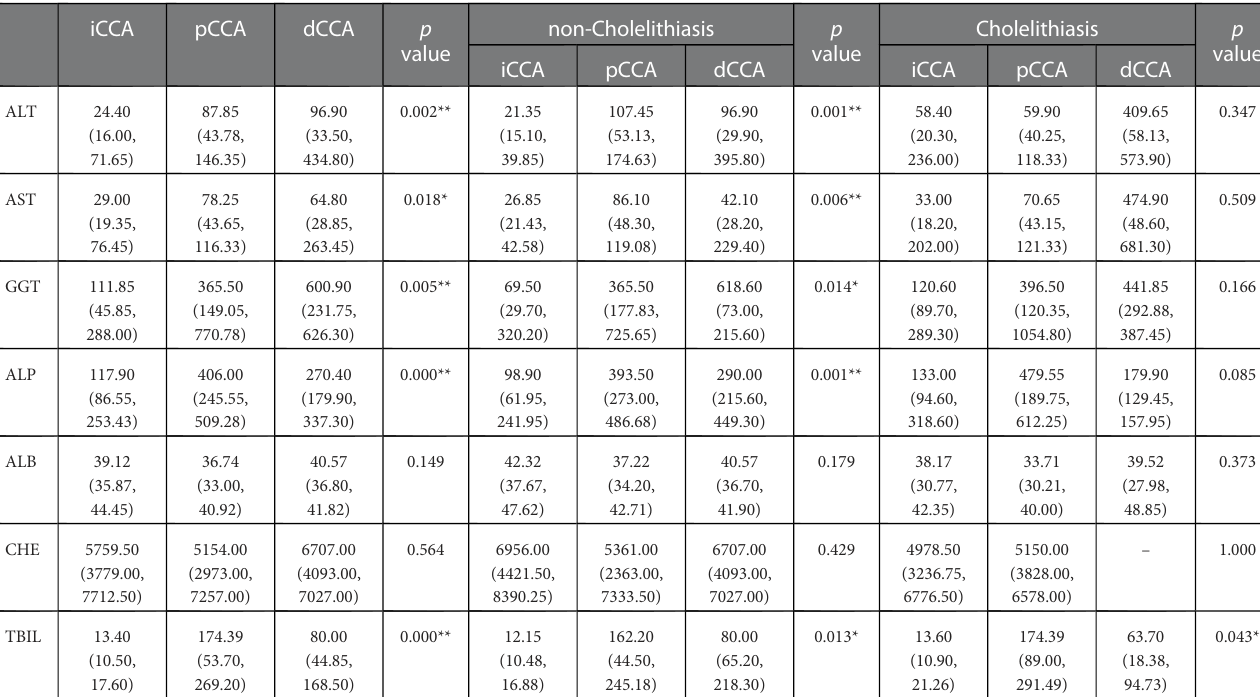
TABLE 3 Liver function in CCA